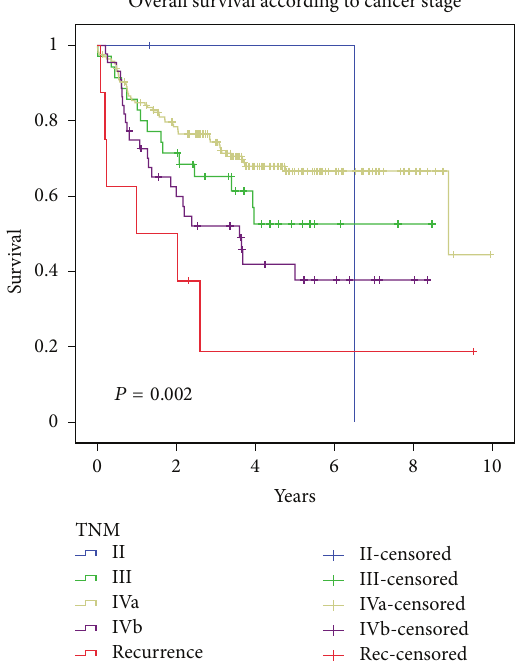
Figure 1: Overall survival according to